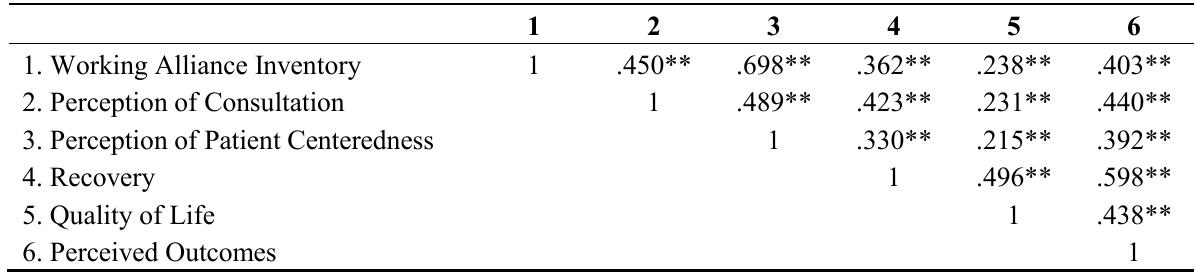
Table 3. Zero order correlations between choice, working alliance and